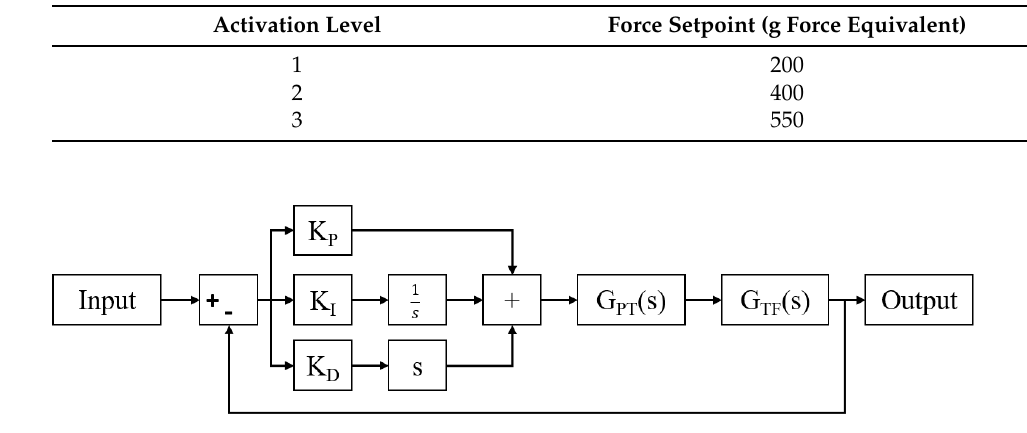
Figure 17. Layout of the control flow for the PID controller. Table 10. Tuned PID